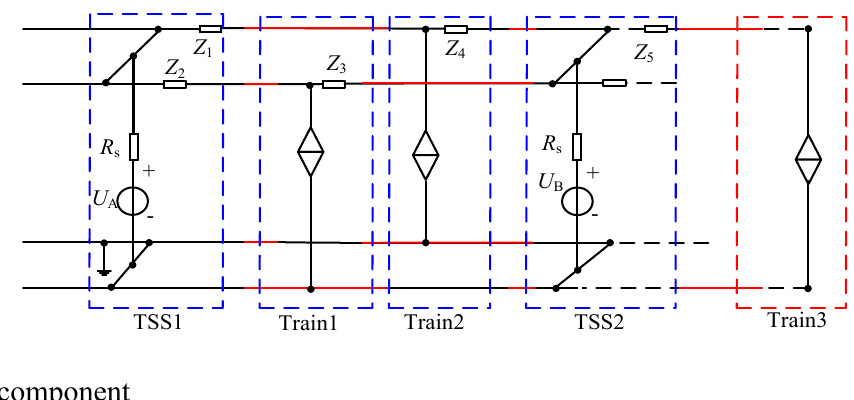
Figure 5. Segmentation of DC electric network.